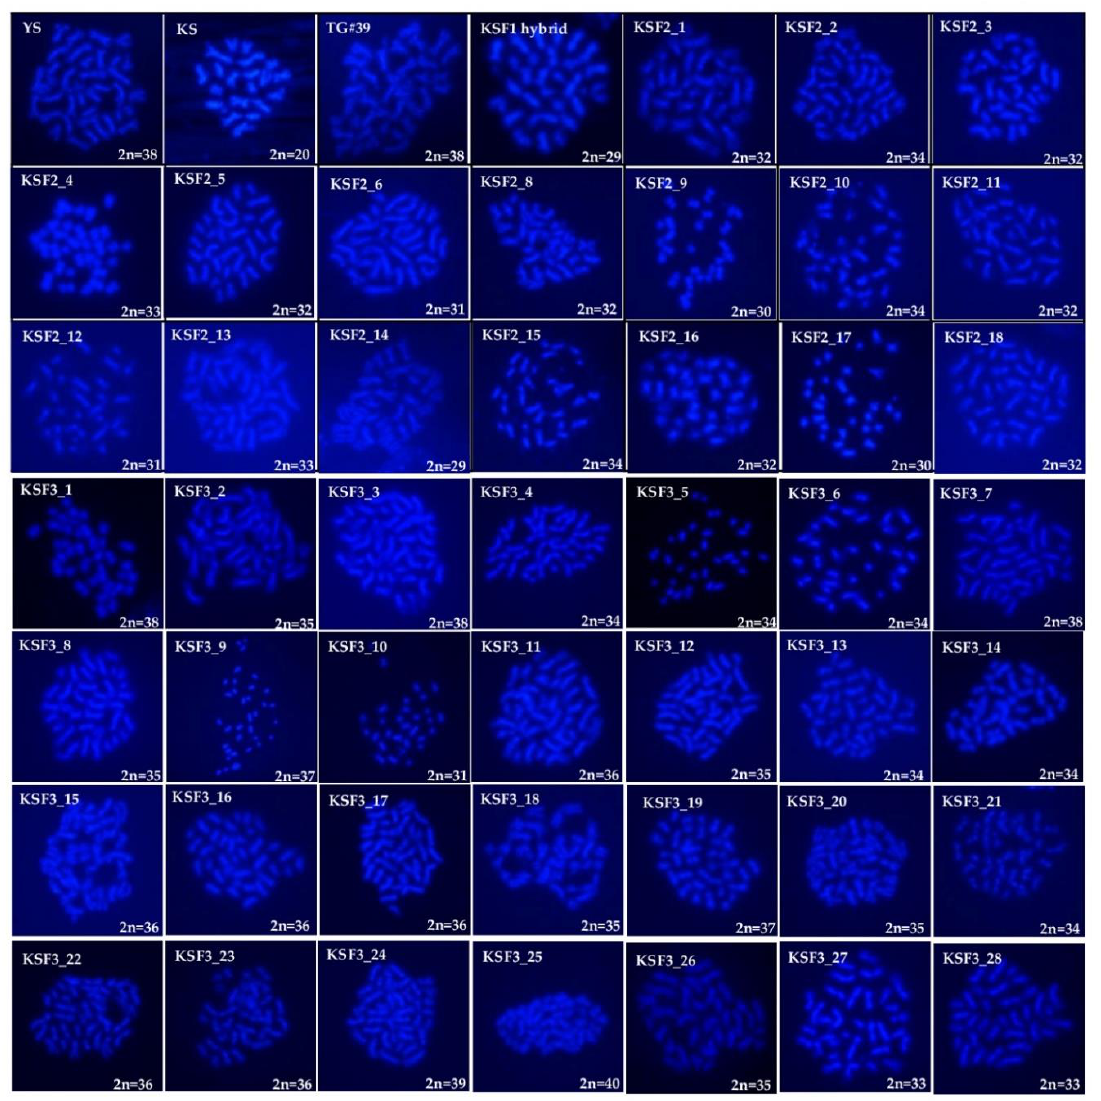
Figure 2. Chromosome counts on non-GM B. napus (YS), B. rapa ssp. rapa (KS), and GM B. napus (TG#39). Cross-combination of B. rapa ssp. rapa ( ♀ ) x GM B. napus ( ♂ ) F 1 hybrids and selfing genera- tion of KSF 2 and KSF 3 .